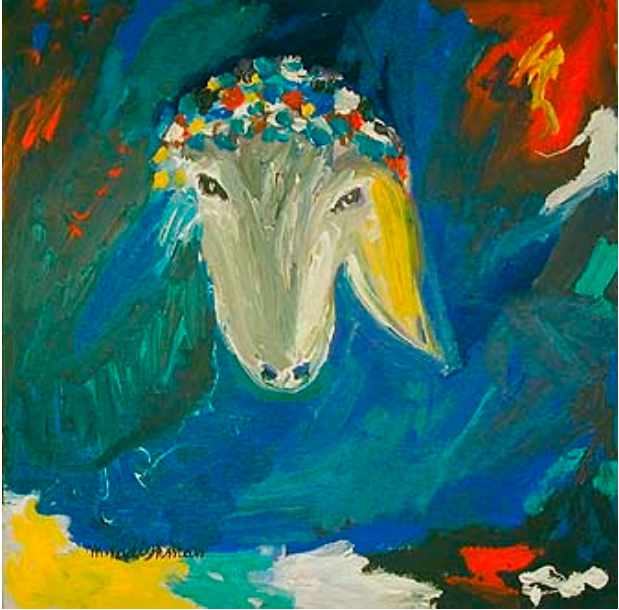
Figure 3. Menashe Kadishman: Sheep Against Blue . 1983. Acrylic on Canvas (41 cm × 46 cm). Photograph by the author.